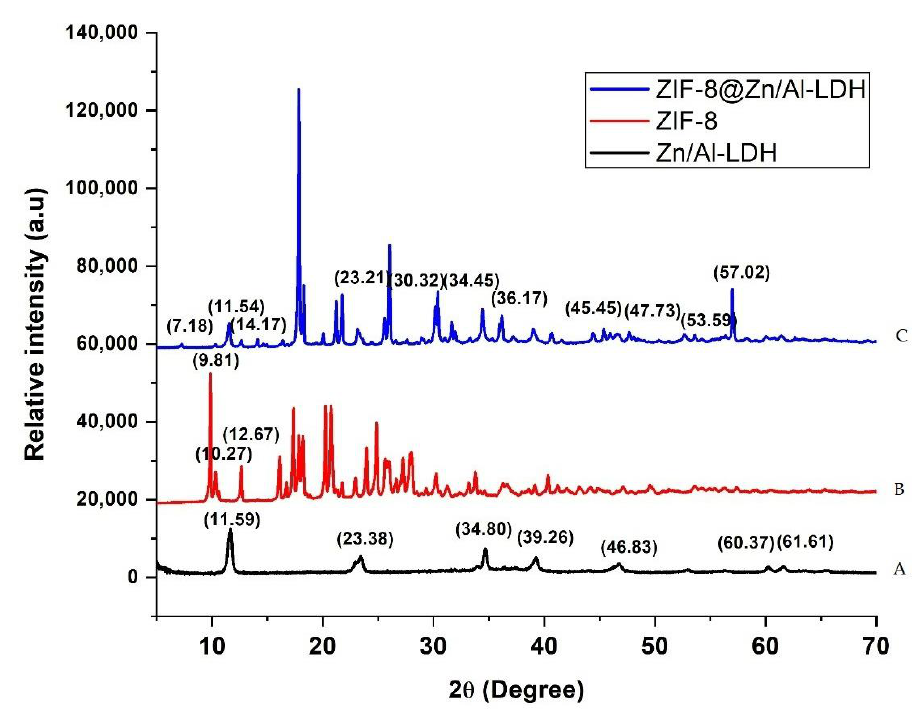
Figure 1. XRD pattern of ( A ) Zn − Al − LDH, ( B ) ZIF-8, and ( C ) Zn − Al − LDH@ZIF − 8 nanocomposites.